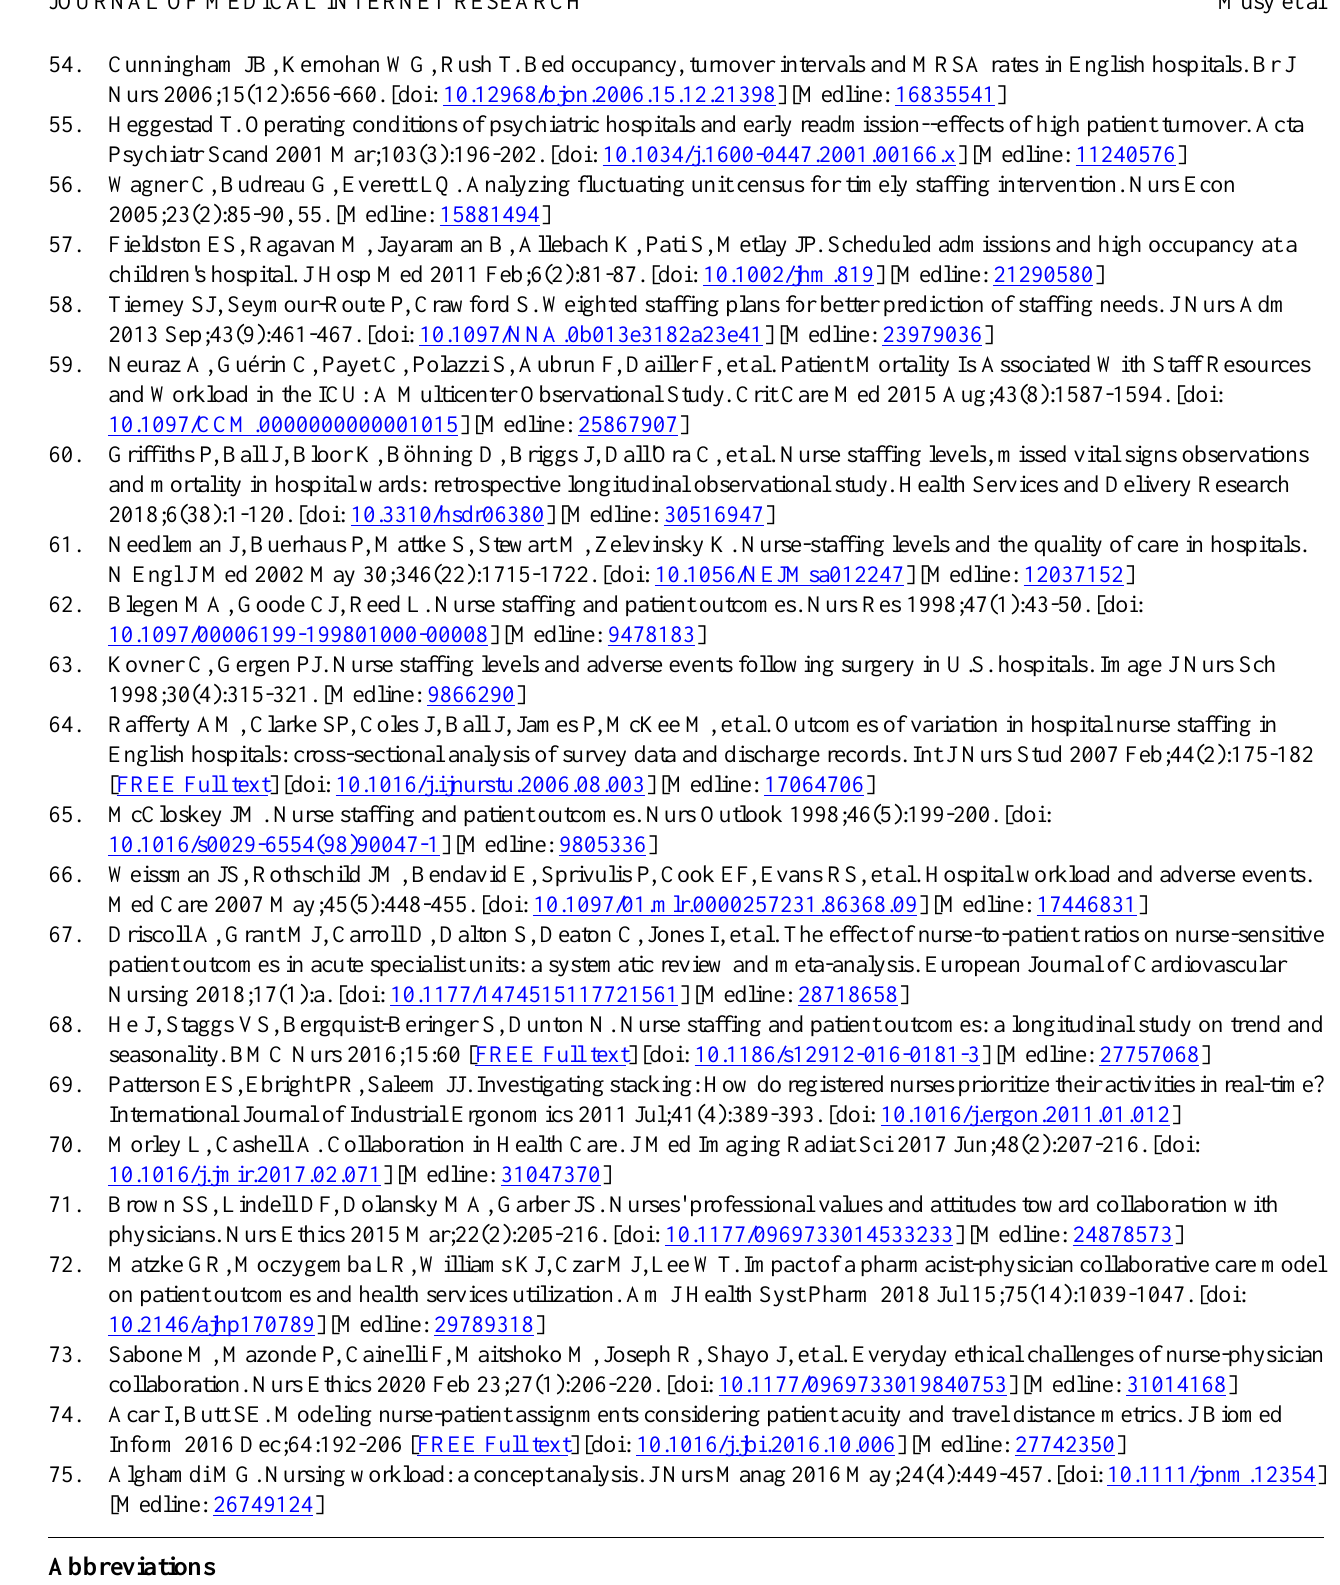
LPNs: licensed practical nurses. RNs: registered